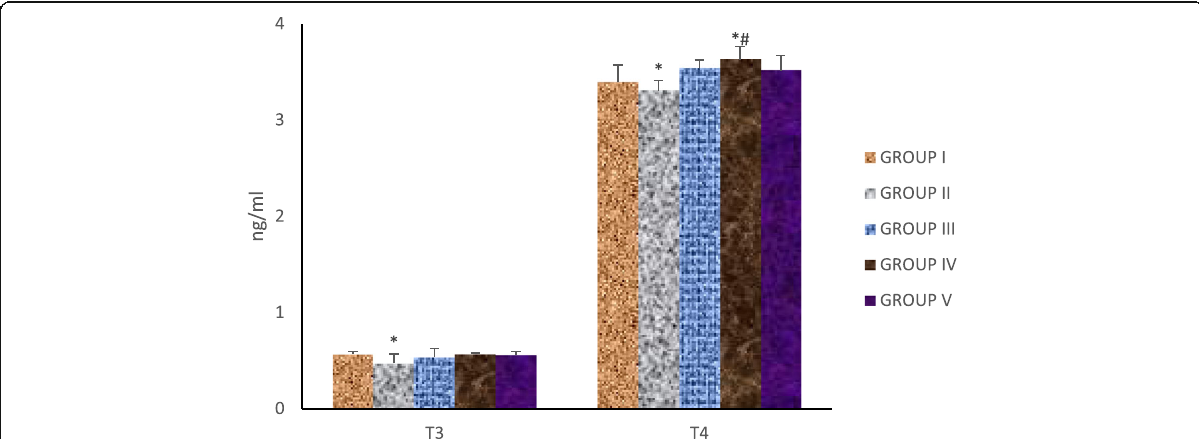
Fig. 5 Effect of MLVA on tri-iodothyronine (T 3 ) and thyroxine (T 4 ) of rats treated with nitrobenzene. Data are given as mean ± SD of rats per group. n = 6. MLVA: methanolic leaf extract of Vernonia amygdalina , *: Values differ significantly from group I (control) ( P < 0.05). #: Values differ significantly from group II